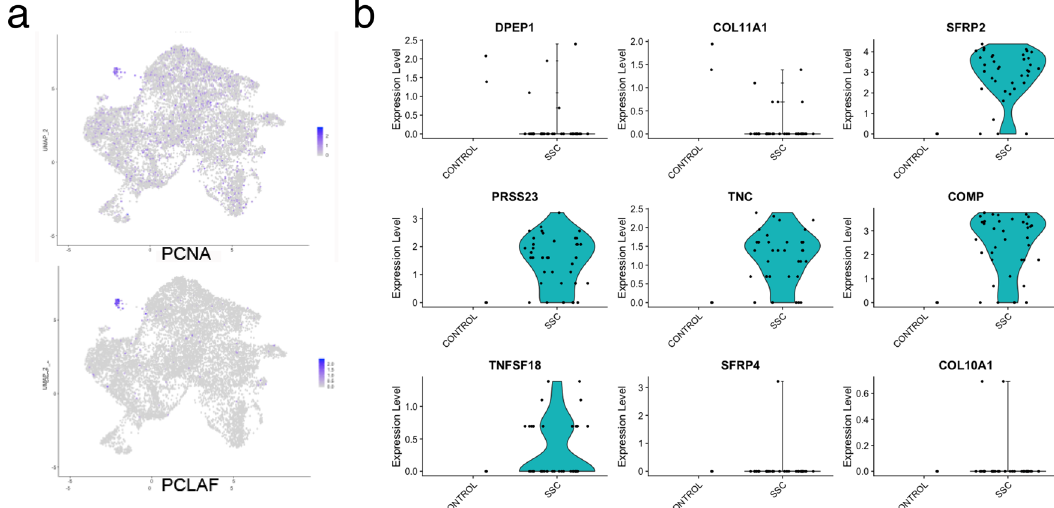
Fig. 6 Proliferating fi broblasts in healthy control and SSc skin. Feature plots indicating that expression of proliferation markers, PCNA and PCLAF , are limited to cells in cluster 9 ( a , b ). Violin plots indicate gene expression by proliferating cells (subcluster 9), showing markers of dermal sheath cells ( DPEP1 and COL11A1 ) by healthy control cells (2 cells) and markers of SFRP2 hi PRSS23 + WIF1 − cells ( SFRP2 , PRSS23 , TNC , COMP , and TNFSF18 ) by SSc fi broblasts (37 cells). Only one SSc fi broblast expressed markers of myo fi broblasts ( SFRP4 and COL10A1 ).